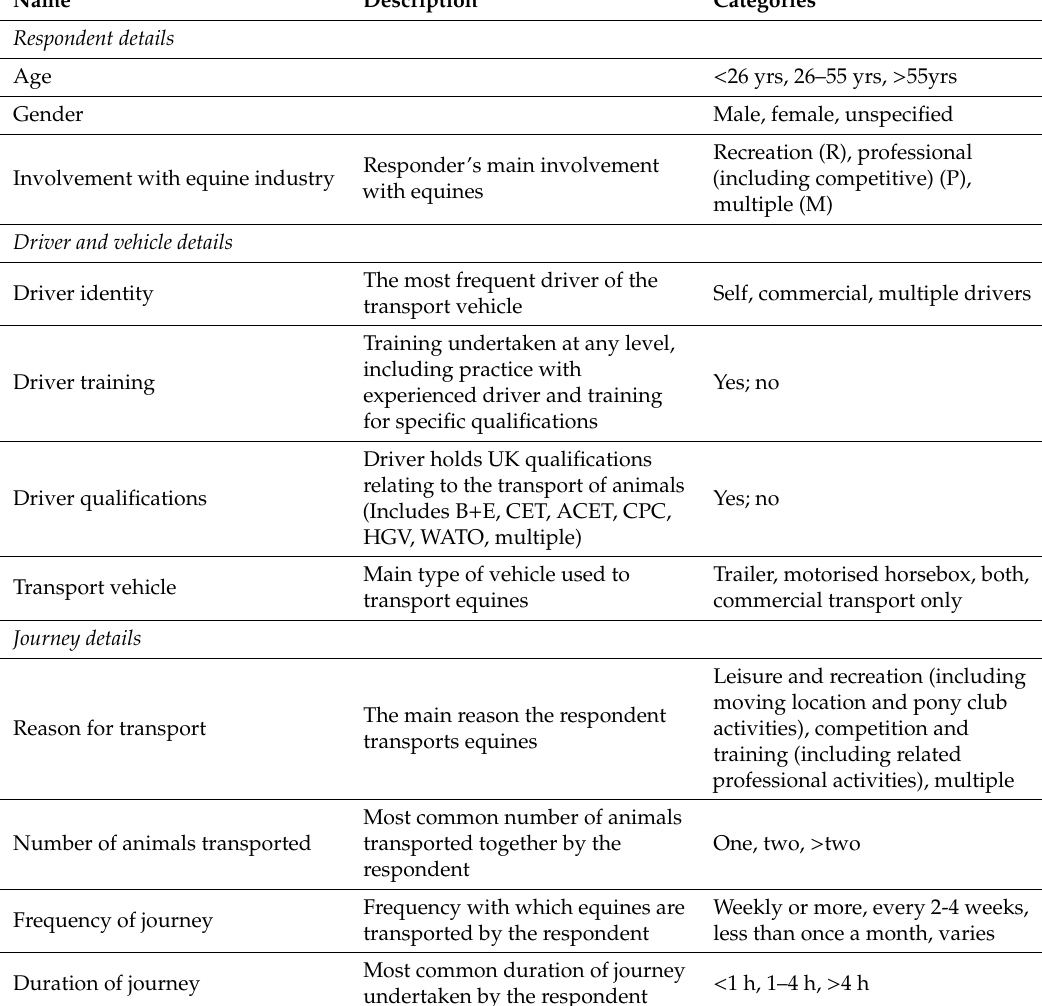
Table 1. Name and description of demographic variables and response categories.